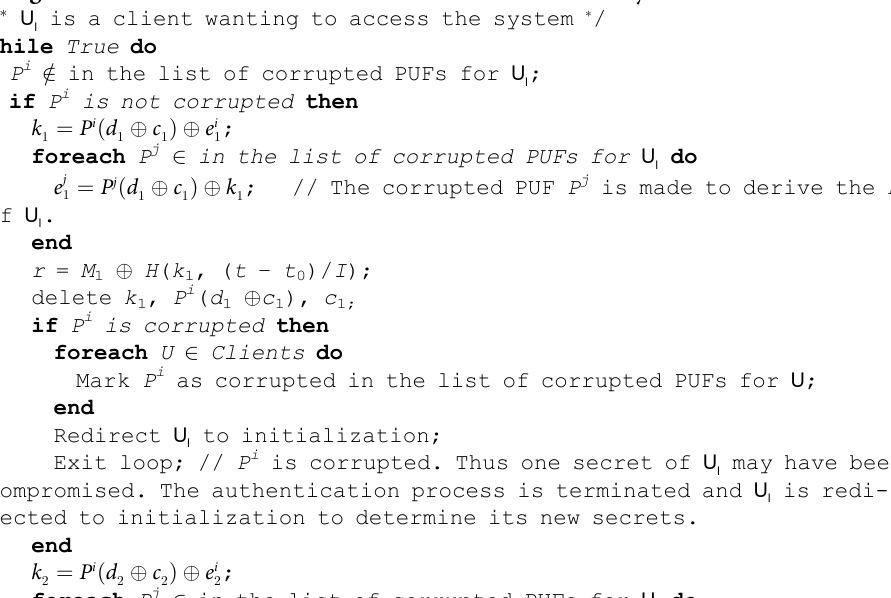
Algorithm 1 : Detailed Authentication Phase with PUF Recovery on Server